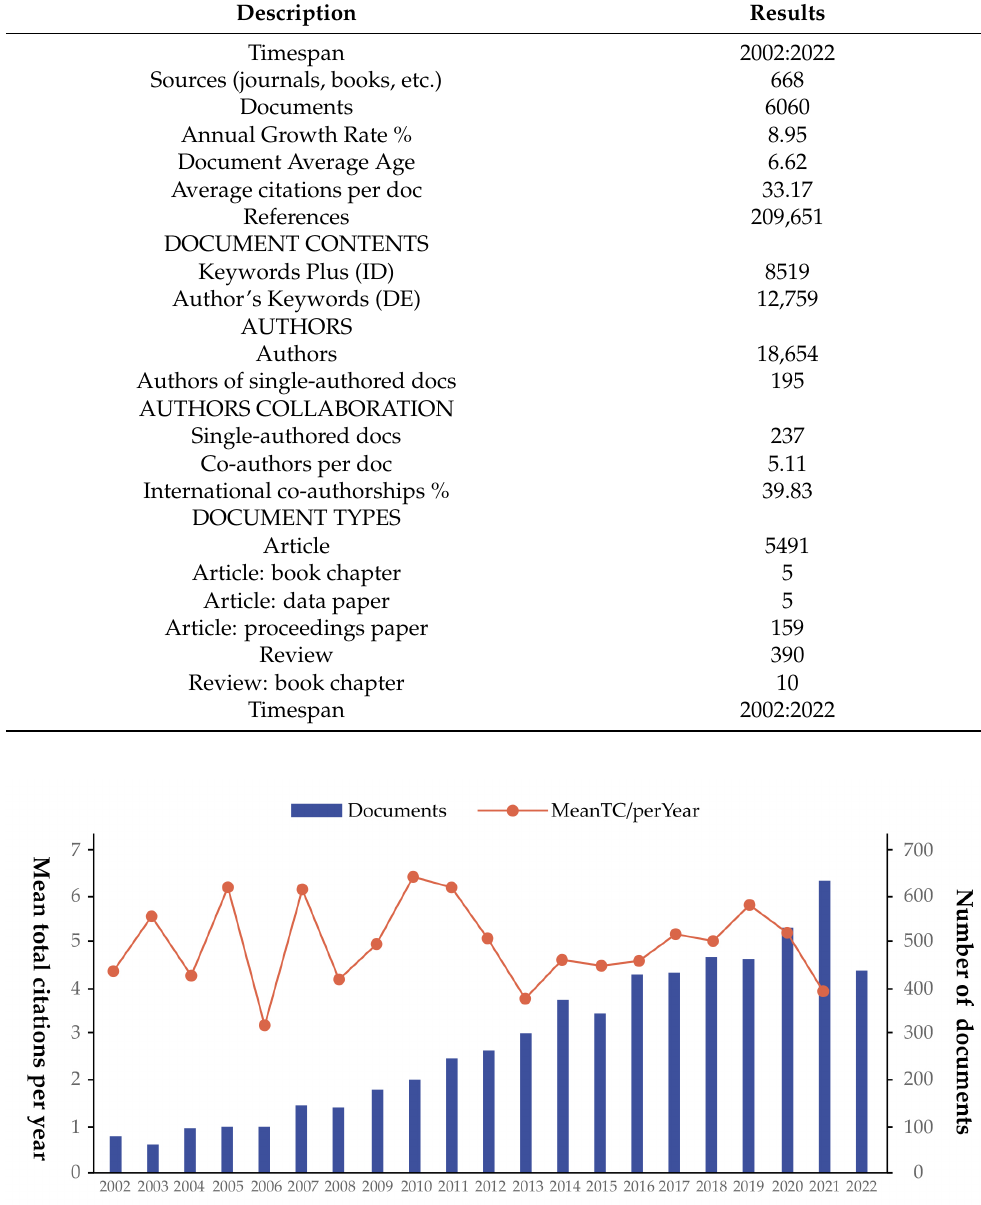
Table 1. Key messages from forest management research in the context of carbon neutrality from 2002 to 2022.